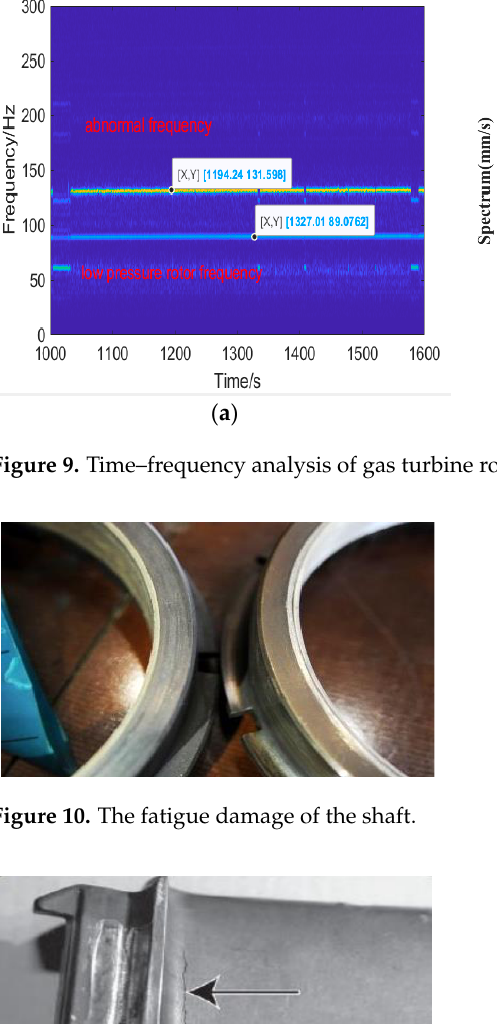
Figure 9. Time – frequency analysis of gas turbine rotor faults. ( a ) Misalignment. ( b ) Unbalanced.